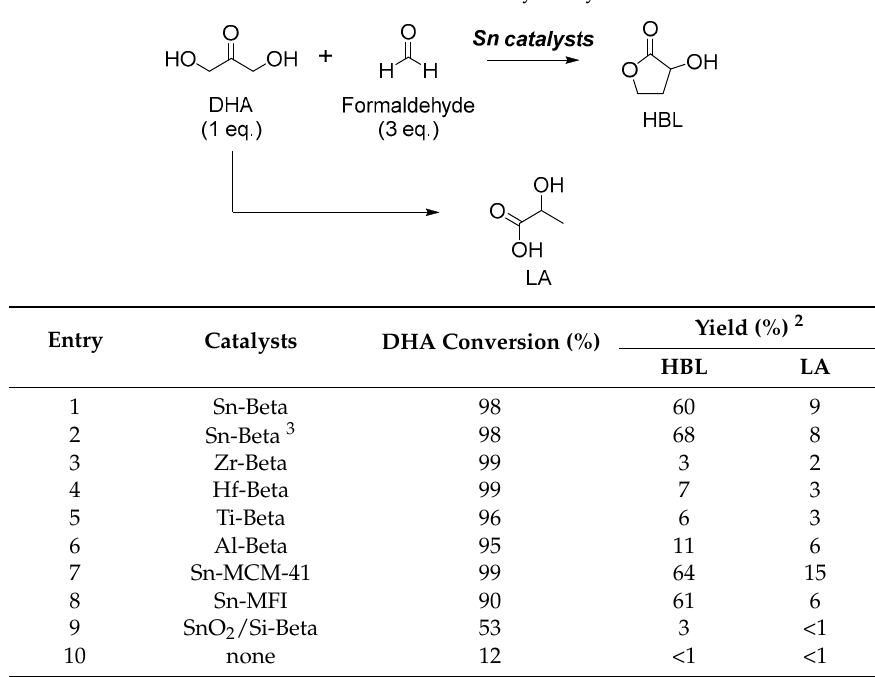
Table 5. Results for the Lewis Acid catalyzed synthesis of HBL 1 .